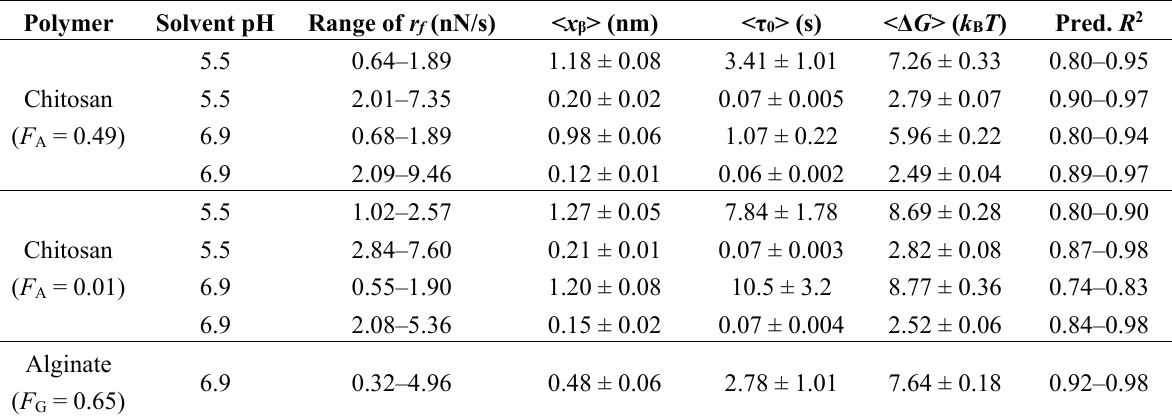
Table 2. Energy landscape parameters obtained for chitosan–mucin and alginate–mucin interactions from the dynamic strength spectrum presentation, i.e. , fits of mean force f versus corresponding mean loading rates r (Equation (1)) with ν 1 2 = f